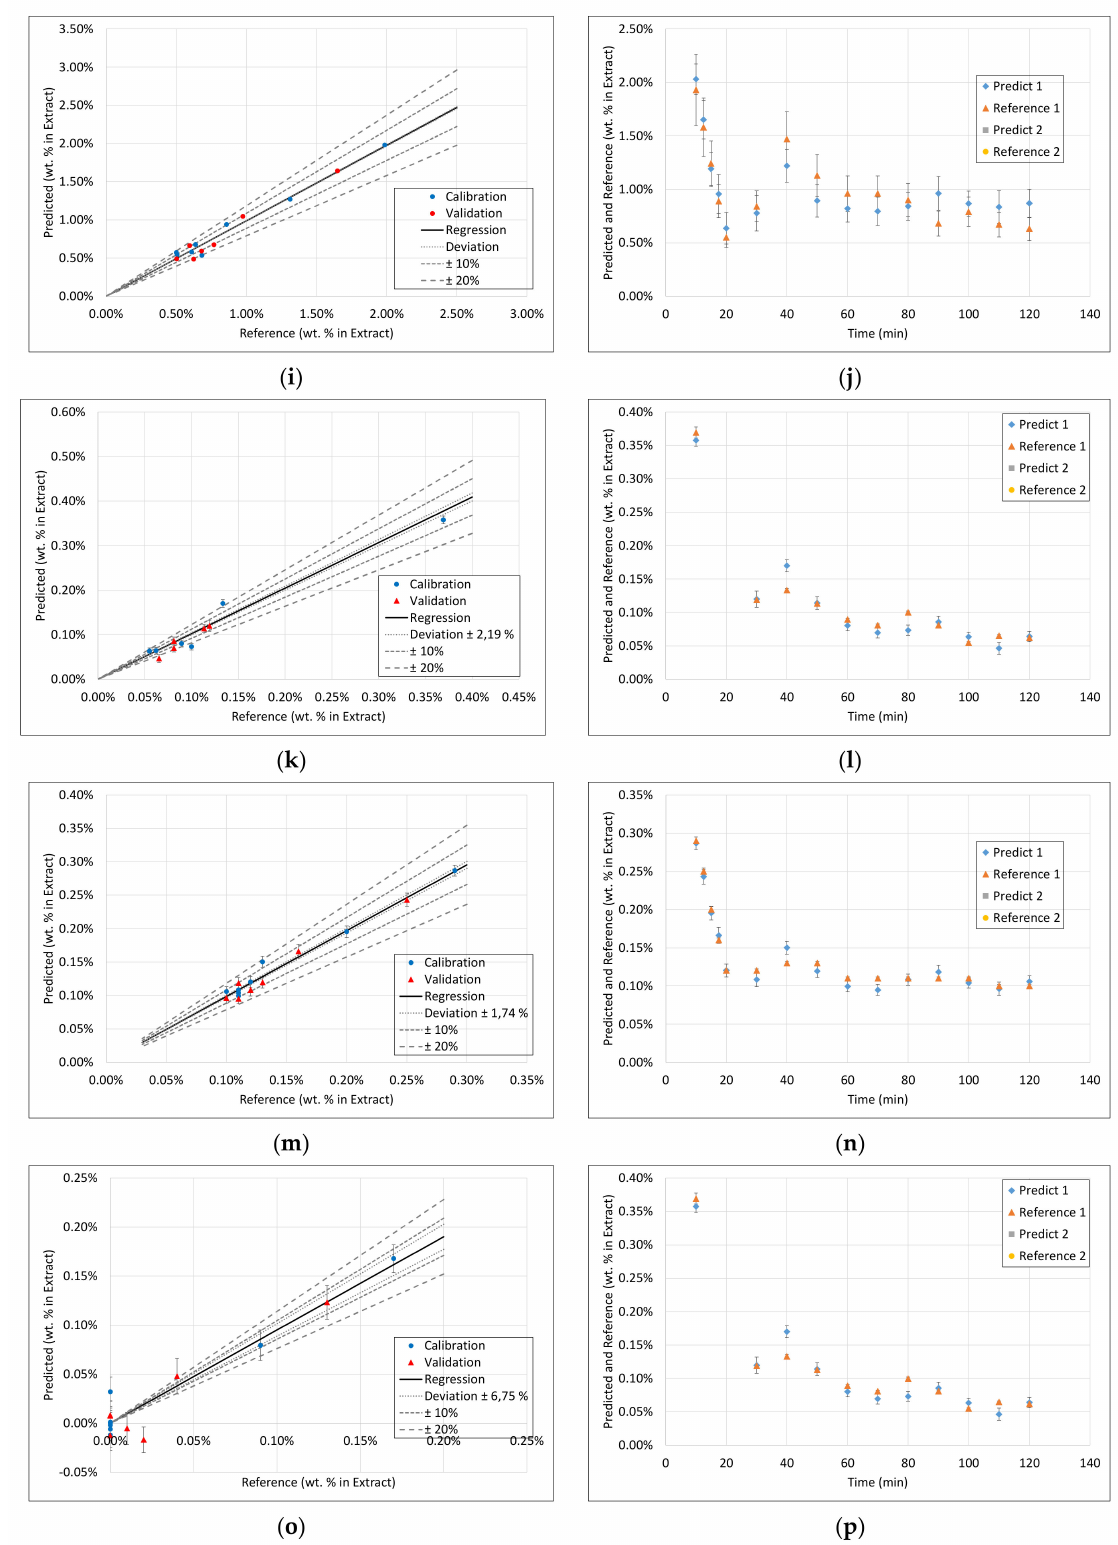
Figure A4. Fluorescence half-normal plots and measured vs. predicted extraction profiles for ( a , b ) dry residue, ( c , d ) arbutin, ( e , f ) total phenolic content, ( g , h ) sugar monomers, ( i , j ) structural carbohydrates, ( k , l ) aminic acids, ( m , n ) proteins, and ( o , p )